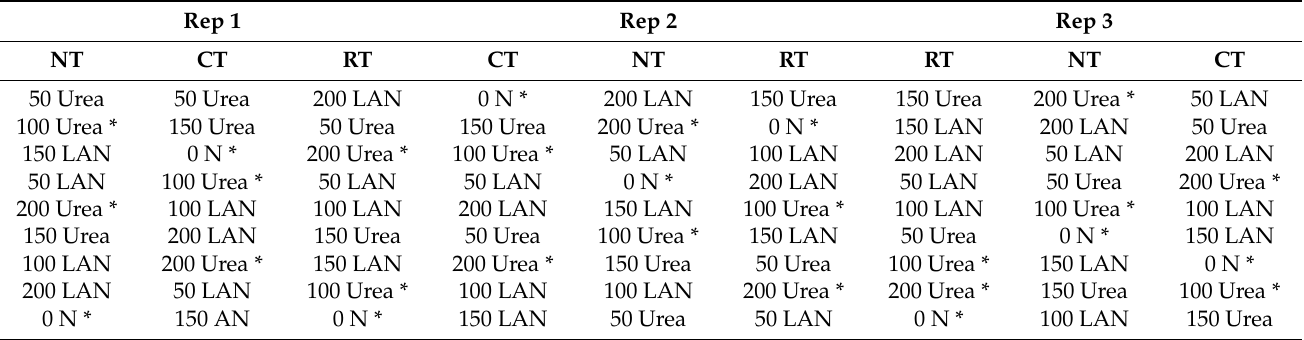
Table 2. Field experimental layout. Coloured blocks represent sampled treatments. NT = no-till, CT = conventional tillage, RT = rotational tillage and LAN = lime ammonium